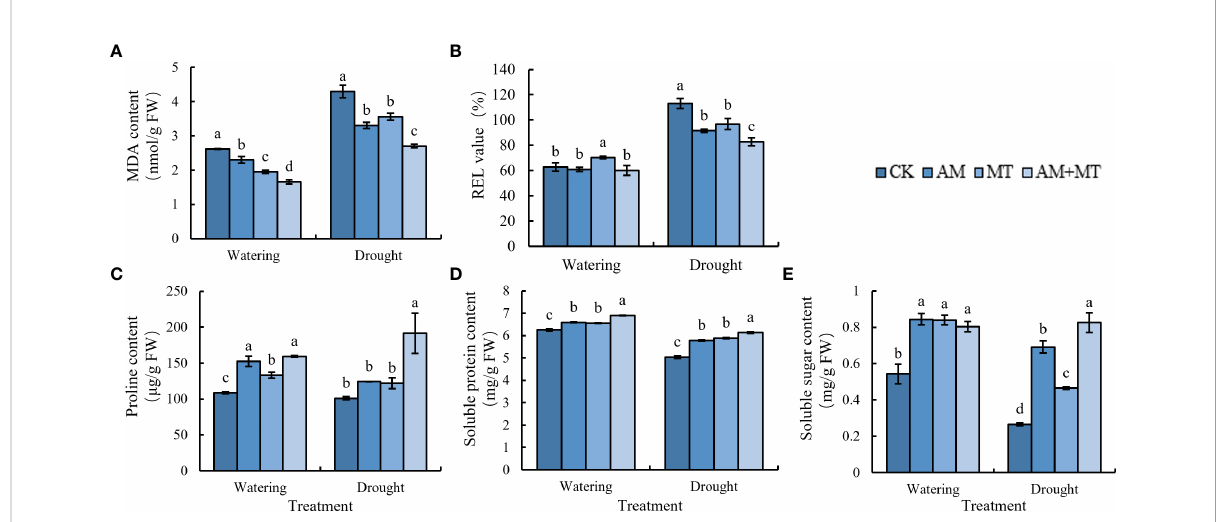
FIGURE 6 Changes of MDA (A) , REL (B) , proline (C) , soluble protein (D) , and soluble sugar (E) in kiwifruit seedlings under well watering and drought stress. Data are presented as meant ± SD ( n = 6), different letters indicate signi fi cant differences between treatments at p < 0.05 by Tukey ’ s Post Hoc test. Treatments included CK (the control), AM (inoculated with arbuscular mycorrhiza), MT (irrigated with 100 m M melatonin), and AM+MT (treated with melatonin and arbuscular